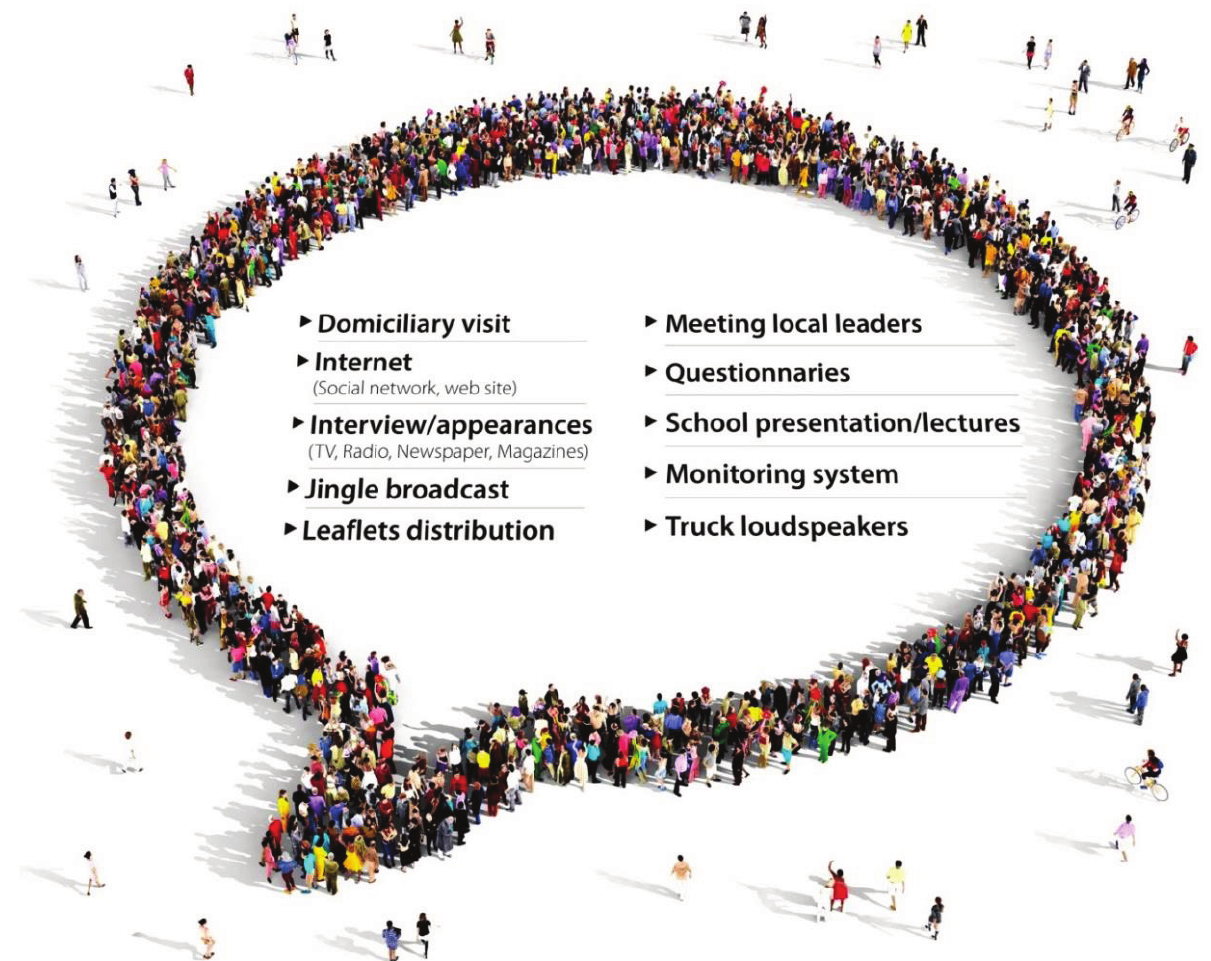
Figure 4. Public engagement activities realized in Bahia, Brazil